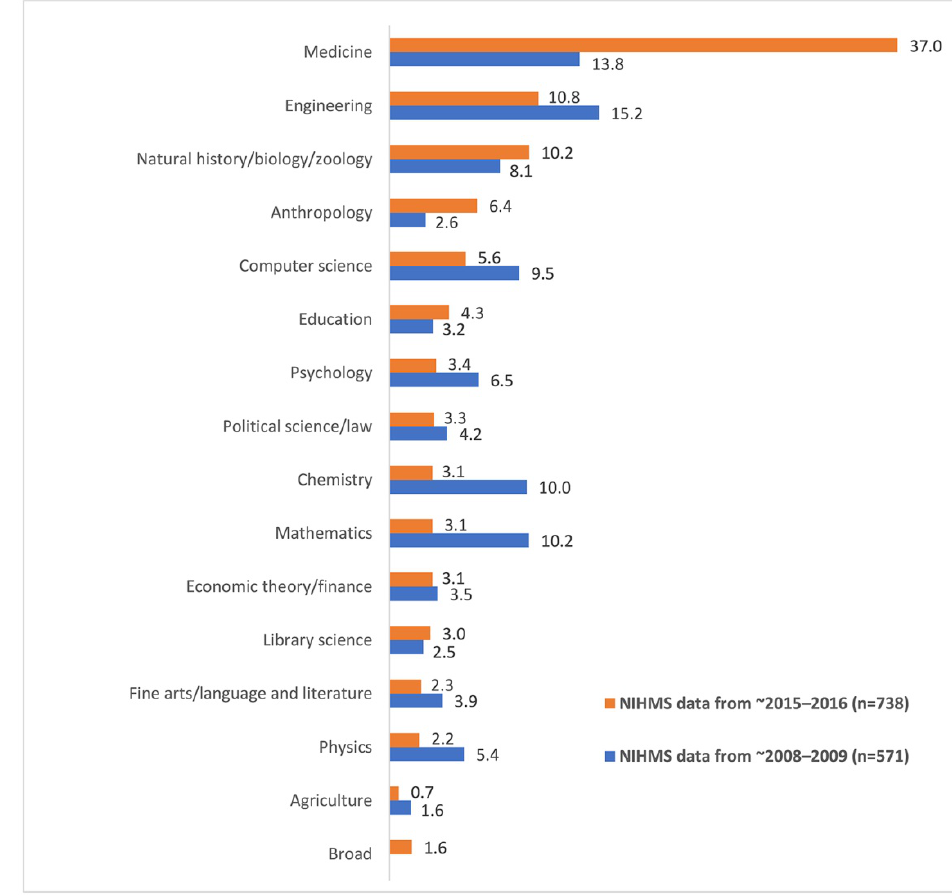
Figure 3 Percentage of publications in the NIHMS datasets by